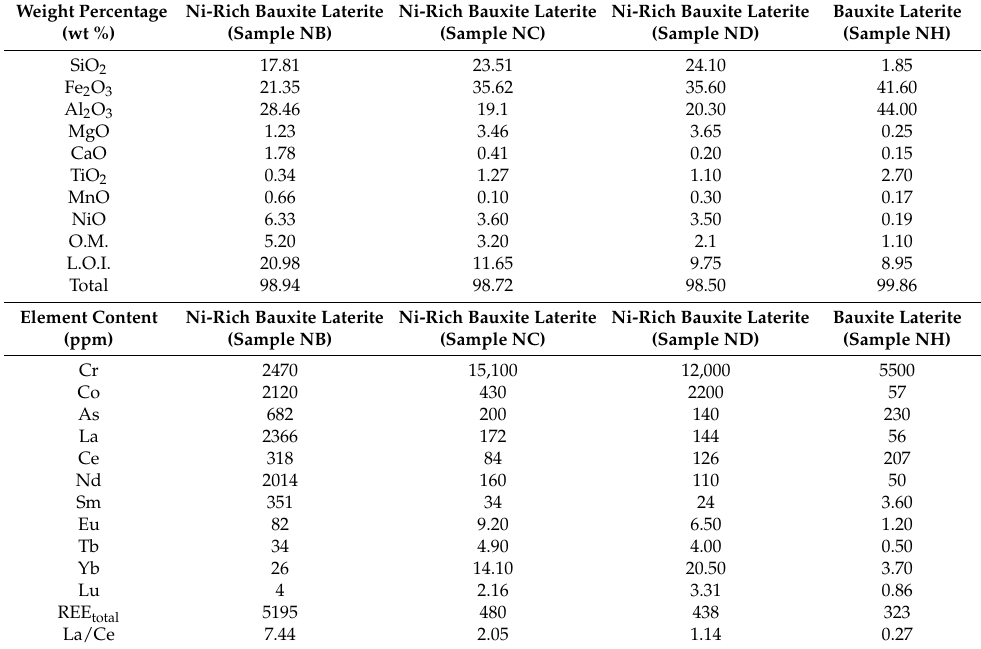
Table 3. Chemical composition of the bauxite laterites from the Patitira Profile II. Weight Percentage (wt